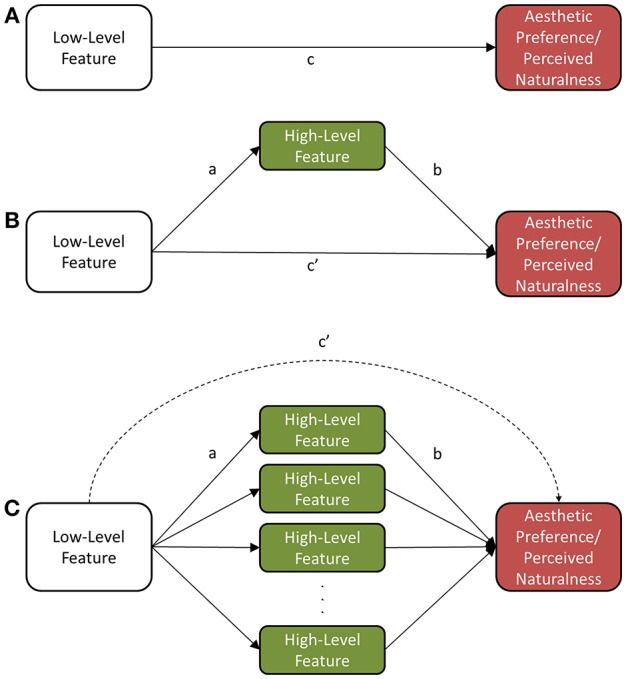
Mediation models. (A) Diagram of Total Effect, path c (no mediators). (B) Diagram of mediation model with one mediator, note direct effect path c′ and indirect effect path a*b which is equivalent to c-c′. (C) Diagram of multiple mediation model.